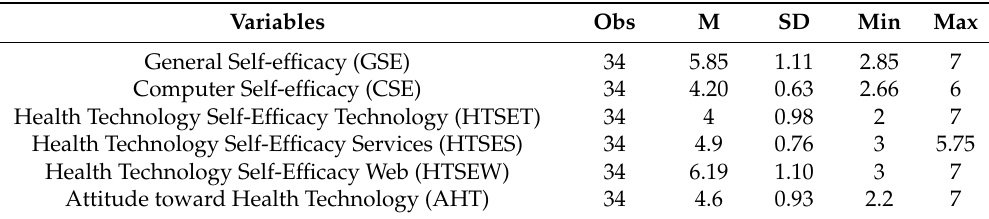
Table 3. Means and standard deviations of diary study participants Healthcare Technology Self-Efficacy (HTSE)